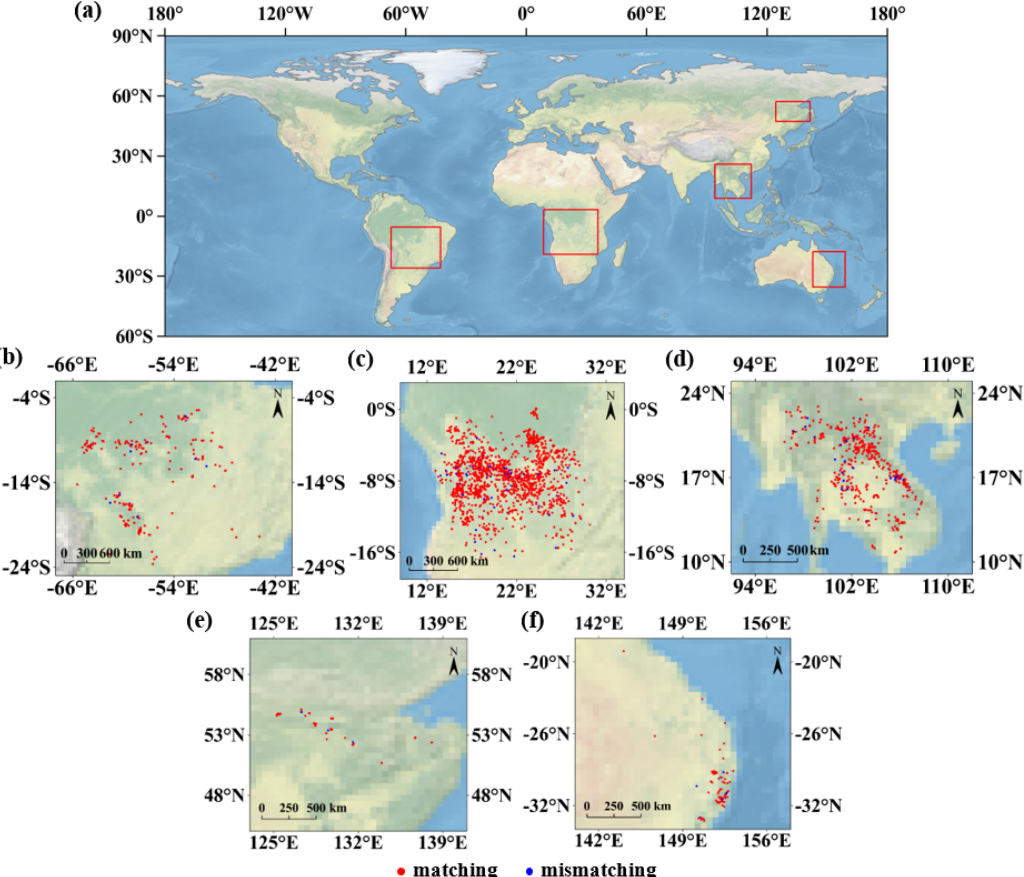
Figure 5. (a) Observation positions from FY-3D MERSI-II. The red frame at the upper right shows FY-3D MERSI-II is located at the border between northeast China and Russia. The lower left red frame shows FY-3D MERSI-II is over east-central South America, and the central red frame shows FY-3D MERSI-II is located in south-central Africa. The middle right red frame shows the FY-3D MERSI-II is over the Indochinese Peninsula, and the lower right red frame shows the FY-3D MERSI-II is located in east Australia. (b–f) Fire spot matching diagram between GFR and visual interpretation data of FY-3D MERSI-II. The red points indicate that GFR matches visual interpretation data, and the blue points represent that only GFR recognized the fire spots.